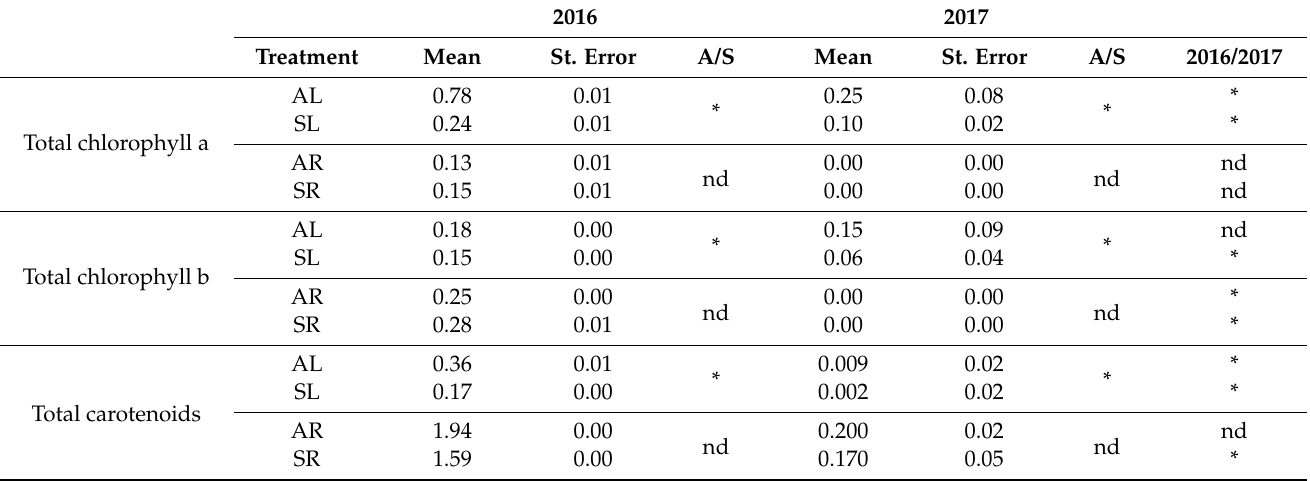
Table 4. Photosynthetic pigments (mg/g dw) in asymptomatic (A) and symptomatic (S) carrot leaves (L) and roots (R).